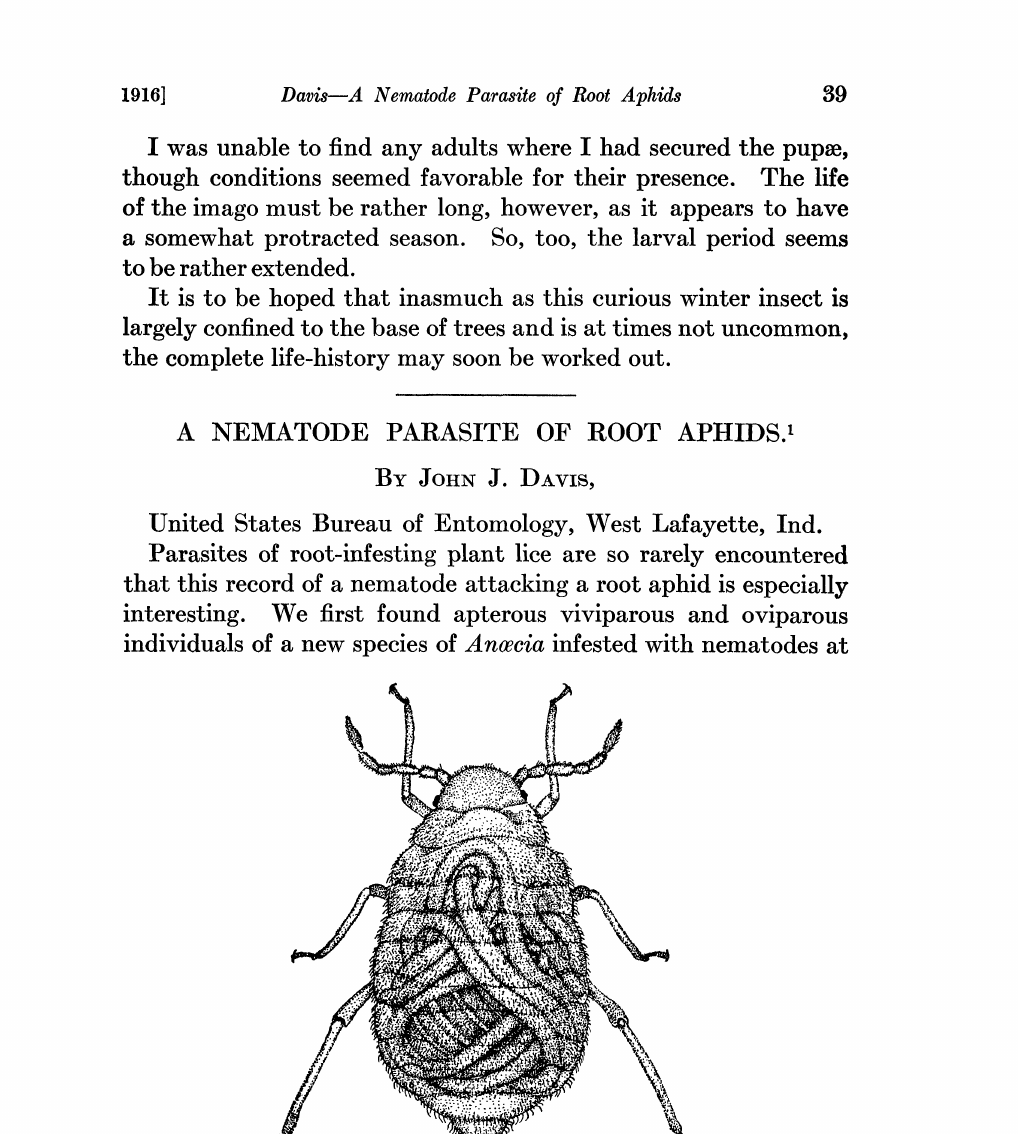
Fig. 1. Ancia sp. infested with a